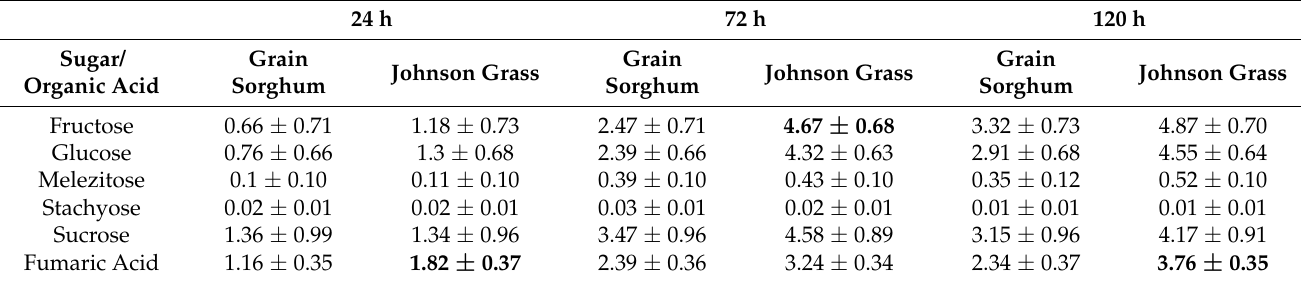
Table 2. Sugar and Organic Acid Concentrations (mg/mL) of Grain sorghum and Johnson grass SA Honeydew over Time. Values Are Mean ± SE of the Mean. As per One-way ANOVA, Bolded Values within Timepoints Indicate Statistical Significance at p <